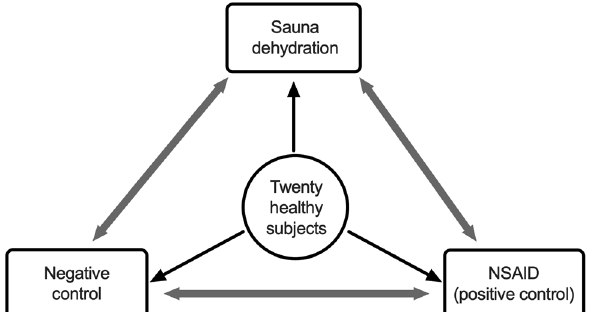
Figure 7. Schematic model of the study design. All 20 subjects participated in all three visits in random order: negative control, sauna dehydration and positive control. Visits were separated by a wash-out period of at least five days.